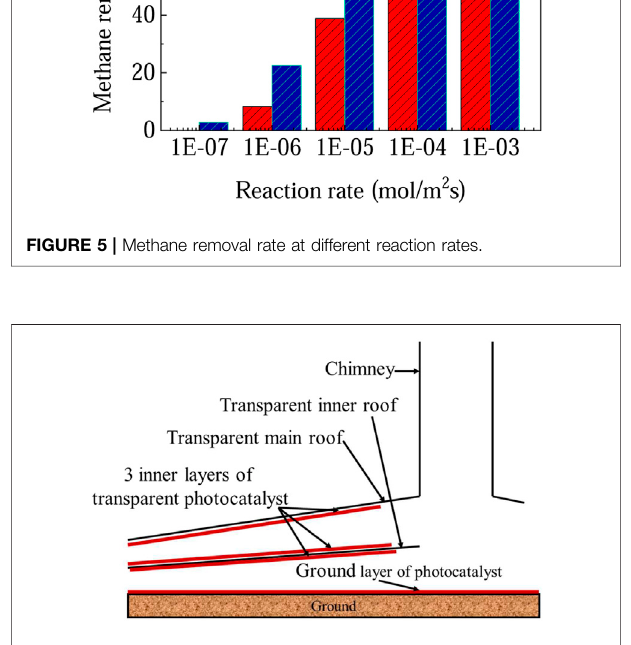
FIGURE 6 | A SUT with double